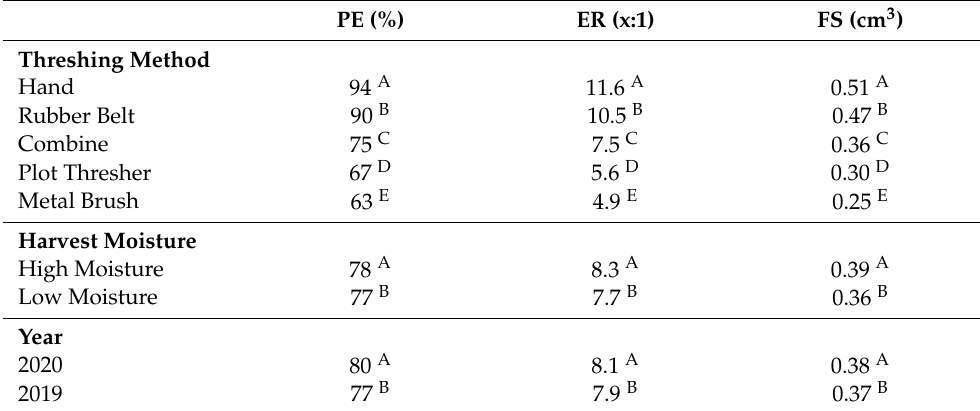
Table 3. Threshing method, harvest moisture and year means separation for popping efficacy (PE), expansion ration (ER) and flake size (FS) from the grain of a Texas A&M pop sorghum hybrid grown in College Station, Texas in 2019 and